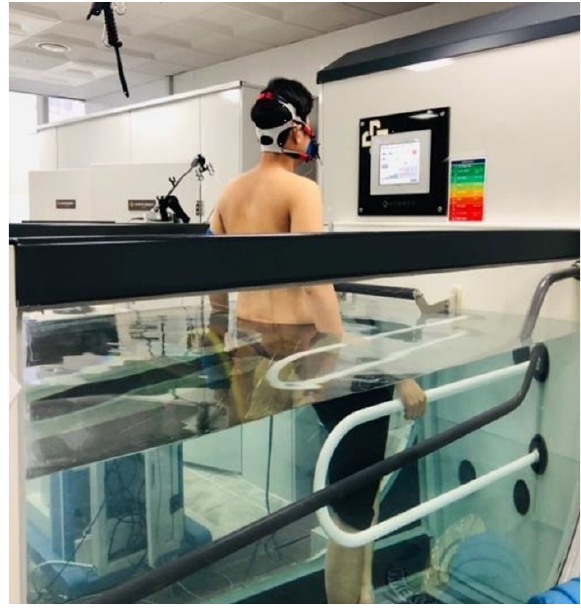
Figure 3. Aquatic treadmill.